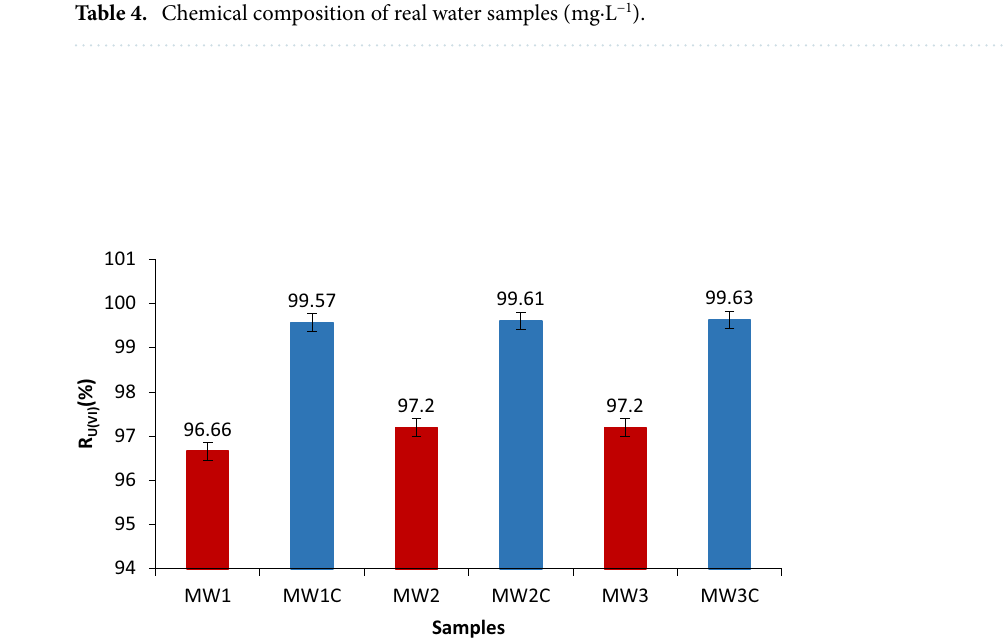
Table 4. Chemical composition of real water samples (mg·L −1 ).